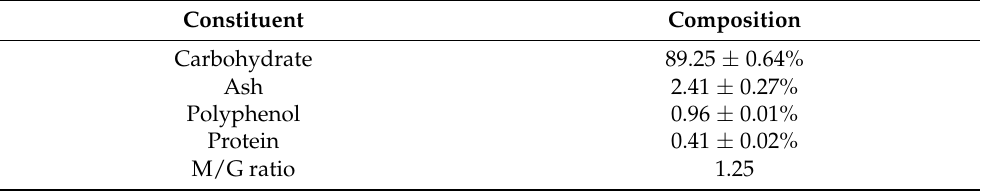
Table 1. Chemical composition of